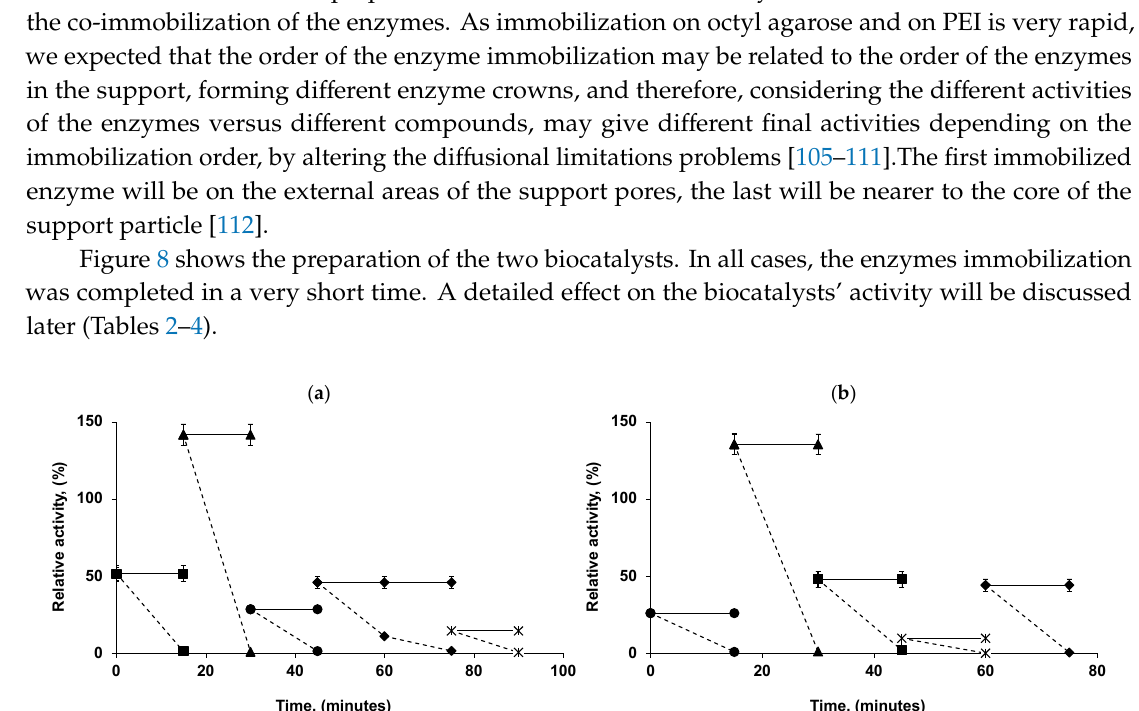
Table 2. Activities of the different individual lipase immobilized biocatalysts versus different substrates. Activities are given as U/g. Activities were determined as stated in Methods.